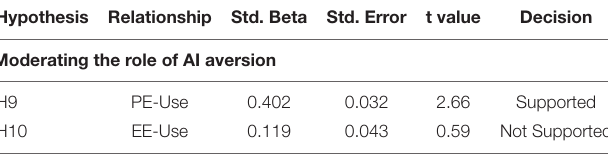
TABLE 6 | Moderating